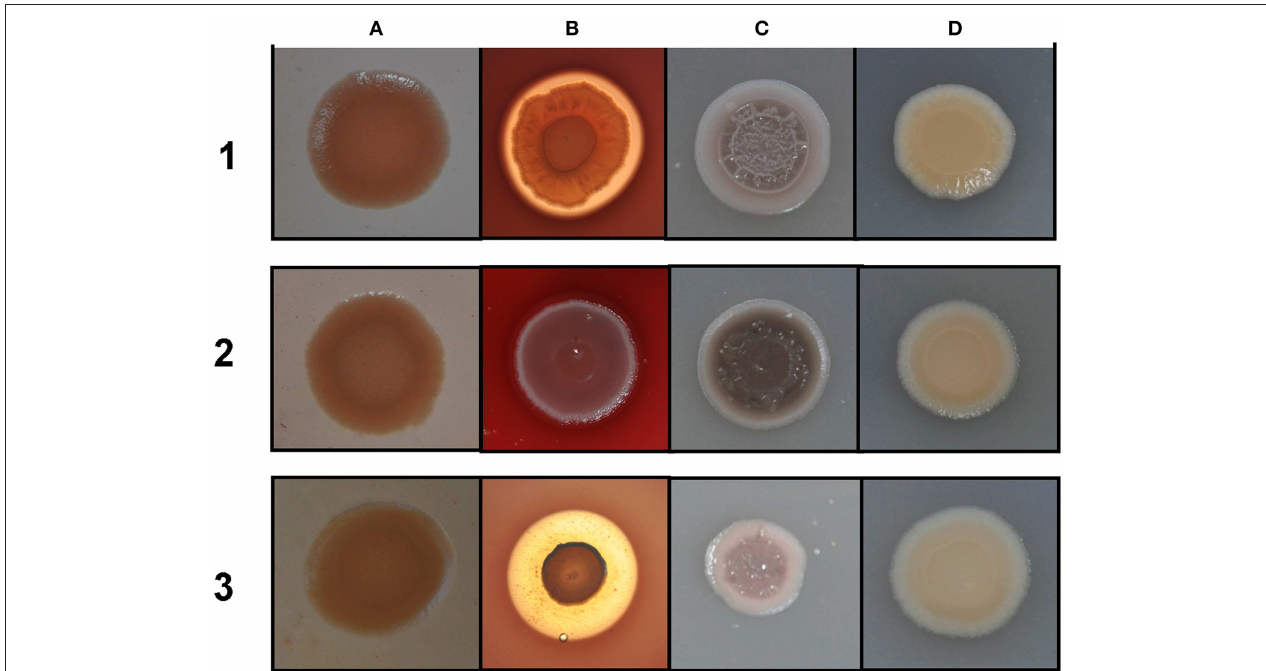
FIGURE 3 | Different colony morphologies of P. aeruginosa on LB agar with Congo red (A), blood agar (B), LB agar supplemented with 4mM FeSO 4 (C), LB agar (D). 1mM IPTG was included in the media for induction. (1) wild type PAO1 with pME6032; (2) icmF3 deletion mutant PAO-F with pME6032; (3) PAO-F with pME6032- icmF3